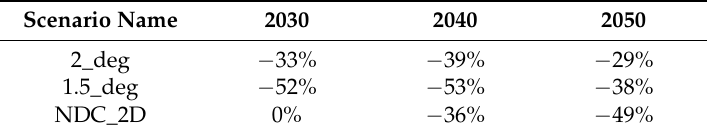
Table 3. Changes in the total primary energy demand in different scenarios compared to the